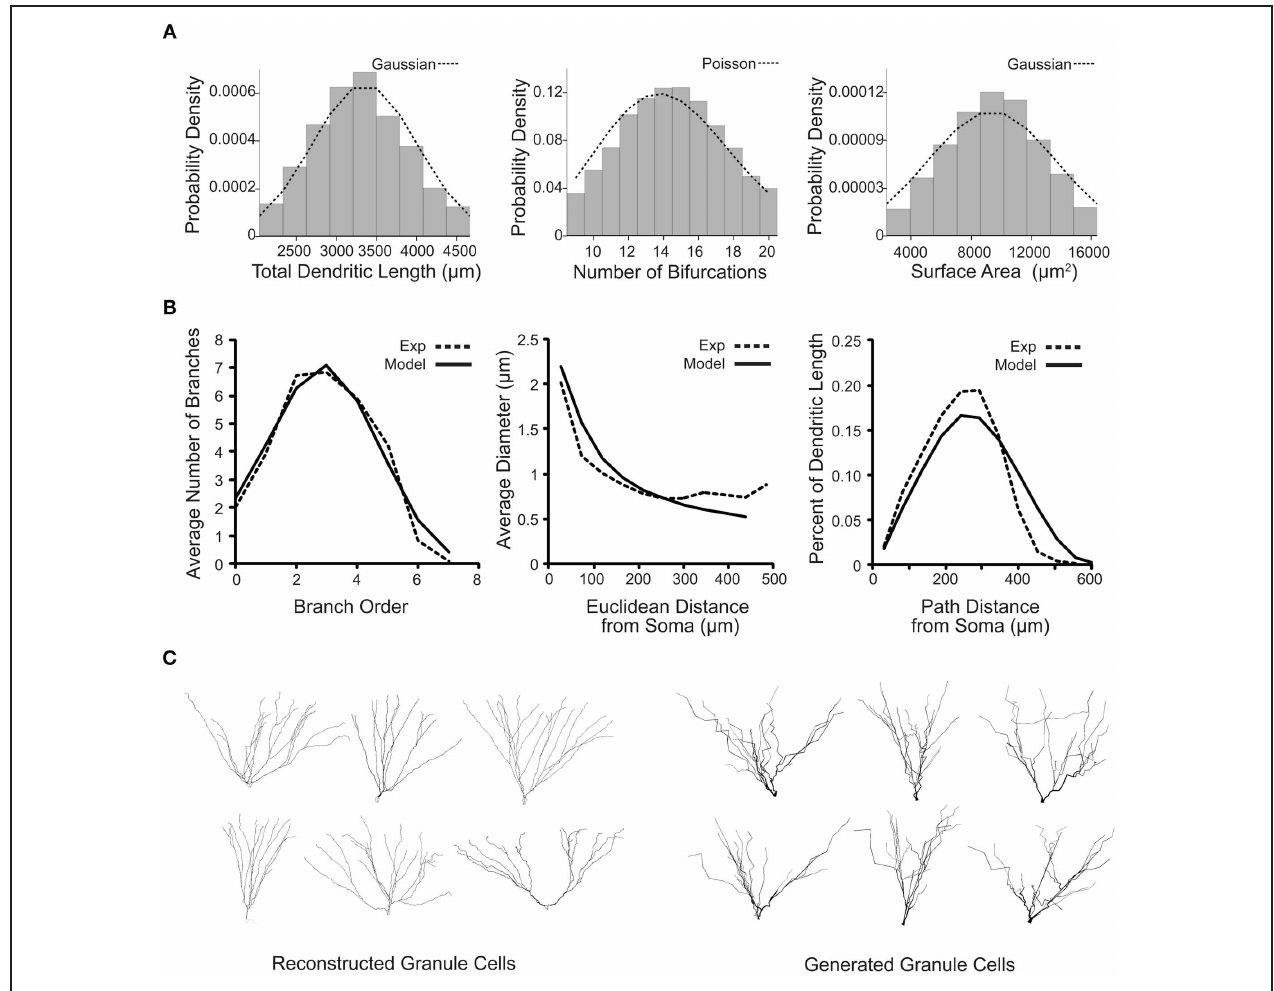
are shown with their ideal respective truncated Gaussian and Poisson probability density functions. (B) Distribution emergent parameters for real (dashed line) and 10,000 generated (solid line) neurons. (C) Sample reconstructed and generated dentate granule neurons, visualized in